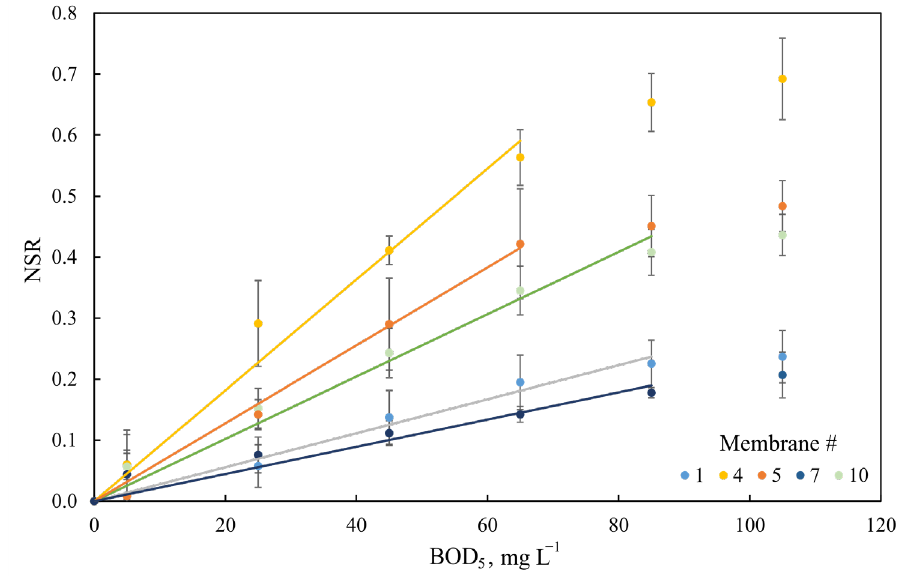
Fig. 9. Calibration graphs of different biosensor membranes at measurement 60 second when OECD wastewater was used for calibration. Different colours indicate different biosensor membranes and linear line indicates the linear range where measurements could be conducted.